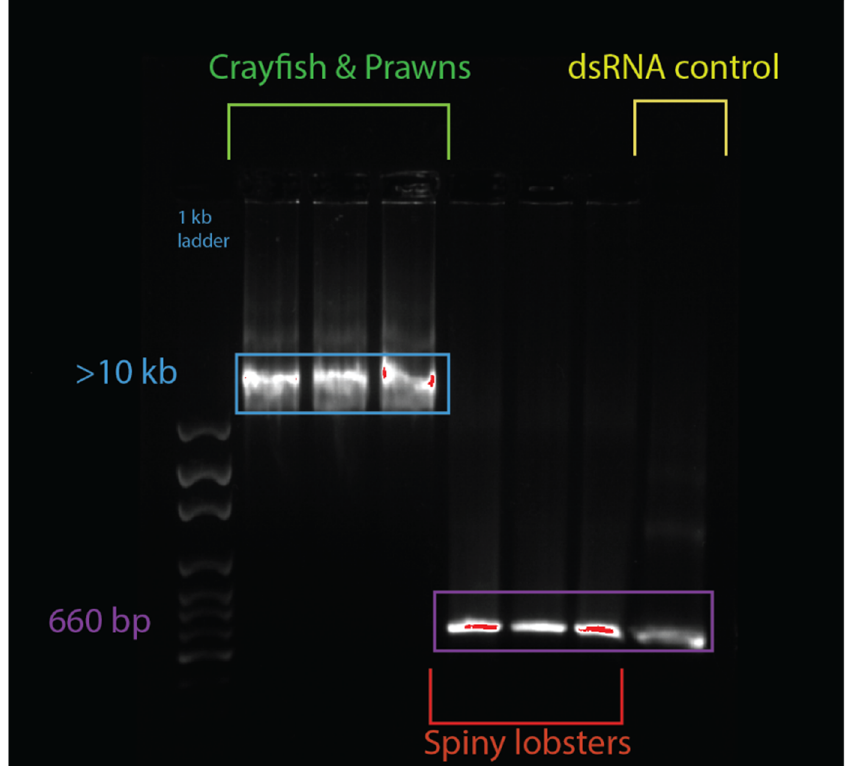
Figure 2. Serum + double-stranded RNA (dsRNA) gel shift observed in various decapod crustaceans. The lanes from left to right contain: 1 kbp ladder, Cherax quadricarinatus serum + dsRNA, Penaeus monodon serum + dsRNA, Macrobrachium rosenbergii serum + dsRNA, Sagmariasus verreauxi serum + dsRNA, Panulirus ornatus serum + dsRNA, Panulirus homarus serum + dsRNA, and a dsRNA + water control. The hemolymph from each species was spun down, then serum was collected and incubated with the same dsRNA for ten minutes. Following this incubation, samples were run on an agarose gel, and a mobility shift was observed in the crayfish and prawn species (in lanes 2–4), which was absent in spiny lobster species (lanes 5–7). The dsRNA control was 660 bp, while the dsRNA incubated with crayfish and prawn serum was at >10 kbp, indicating a protein–RNA interaction distinctly absent from the dsRNA incubated with the spiny lobster serum, which migrated normally to 660 bp, as seen in the control.